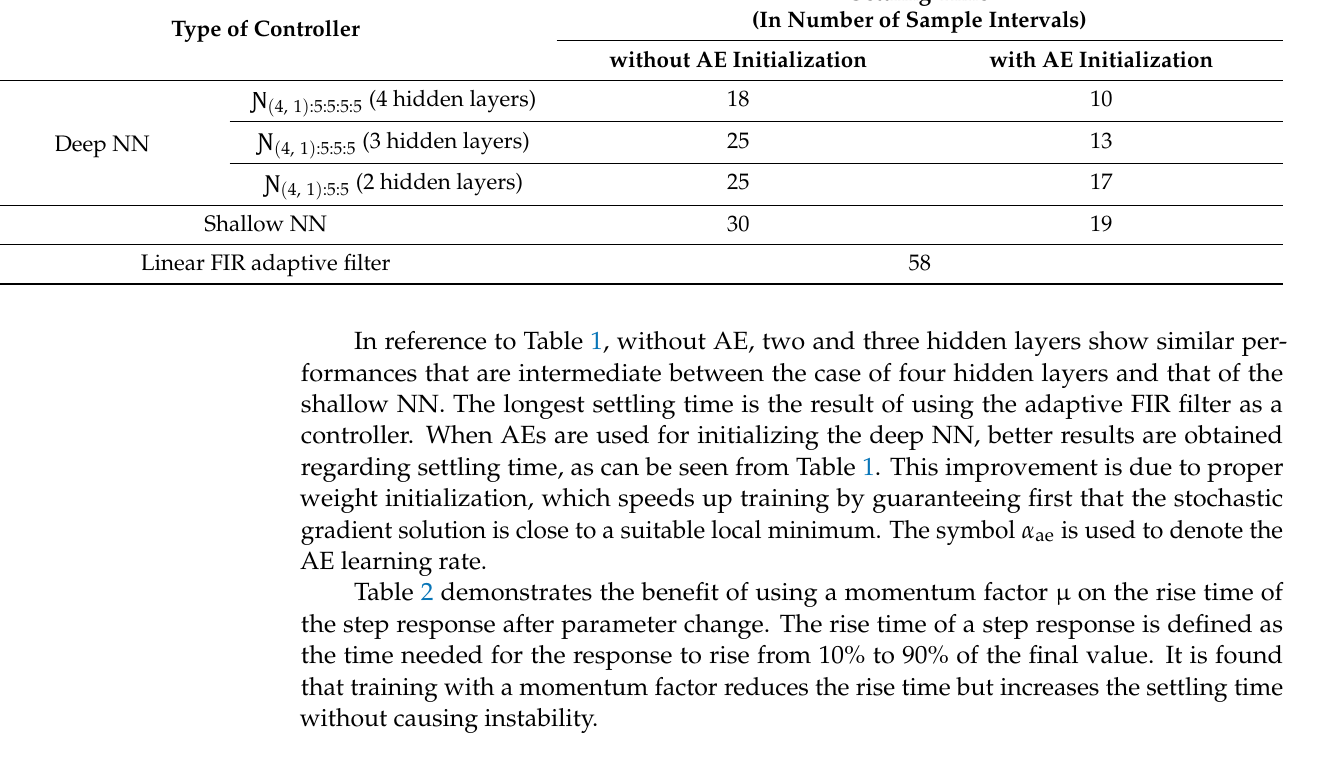
Table 2. Momentum effect on settling time and rise time after nonlinear-plant parameter change (Equation (7)) vs. number of deep NN hidden layers, and when using a linear FIR adaptive filter. α = 0.02, α ae = 0.1, different momentum factor values ( µ ). AE is used for initialization.